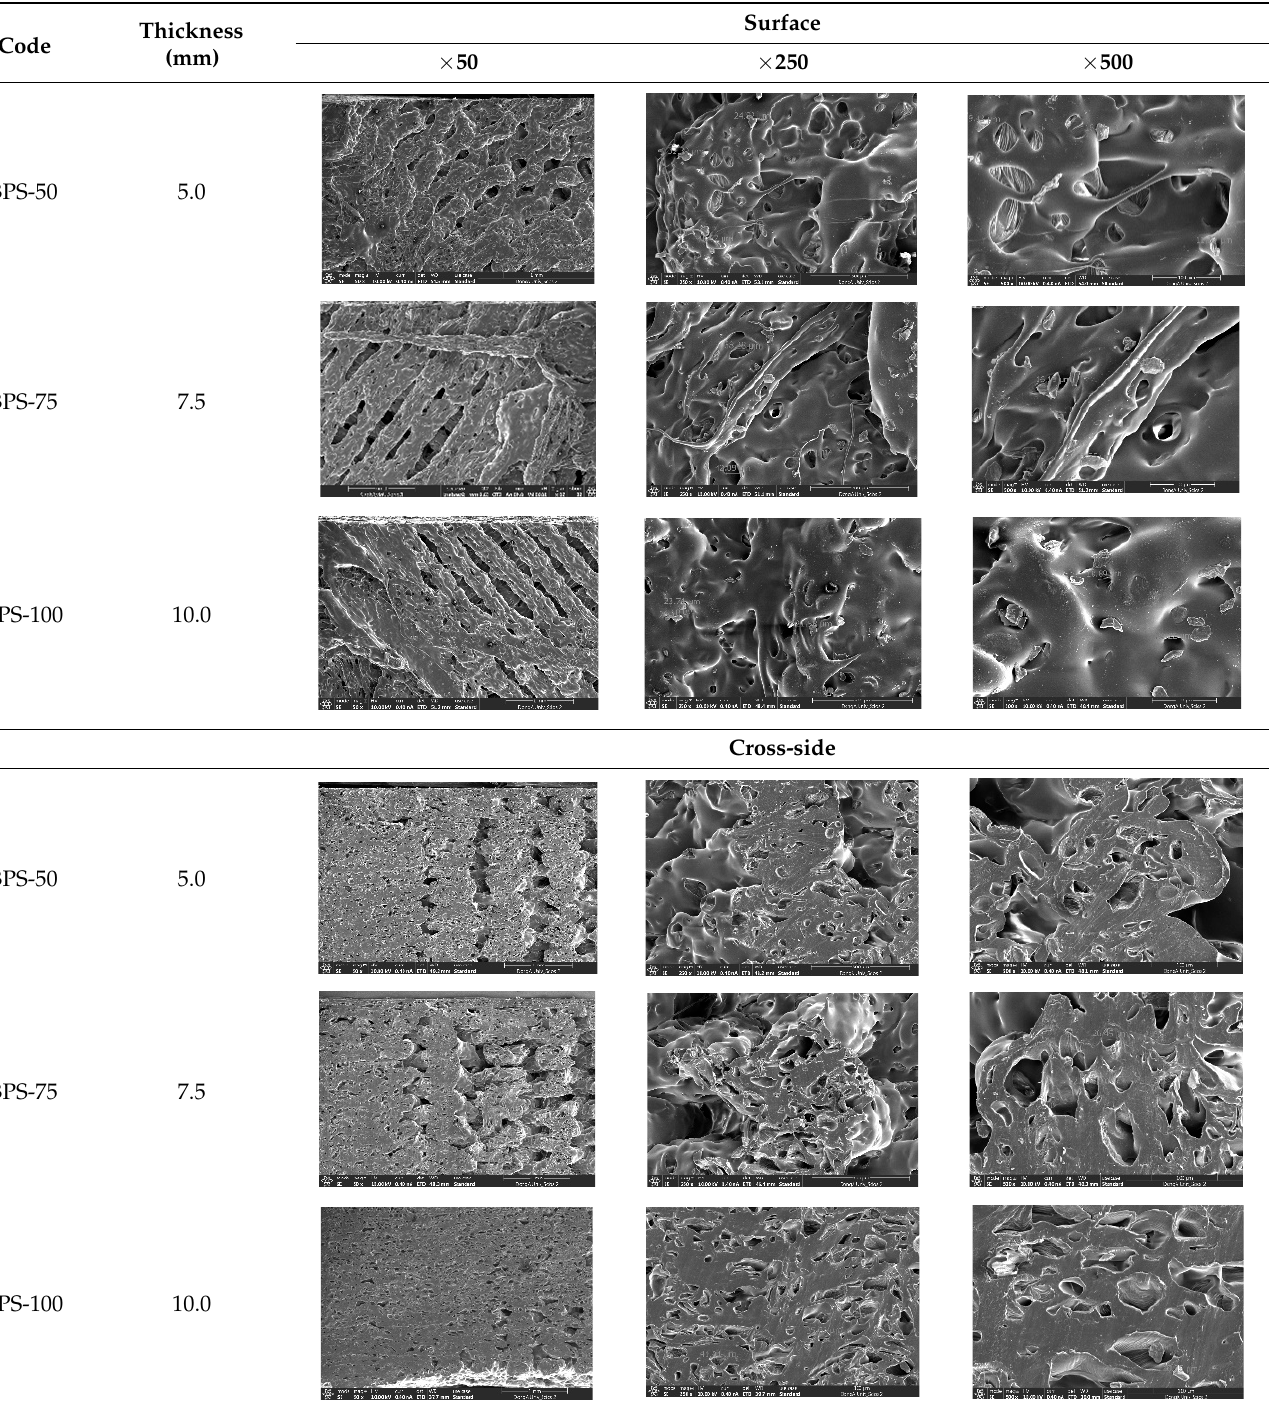
Table 2. Morphology image of surface and cross-side of the LW 3DP 3-PS outsole piece extruded in various thicknesses.